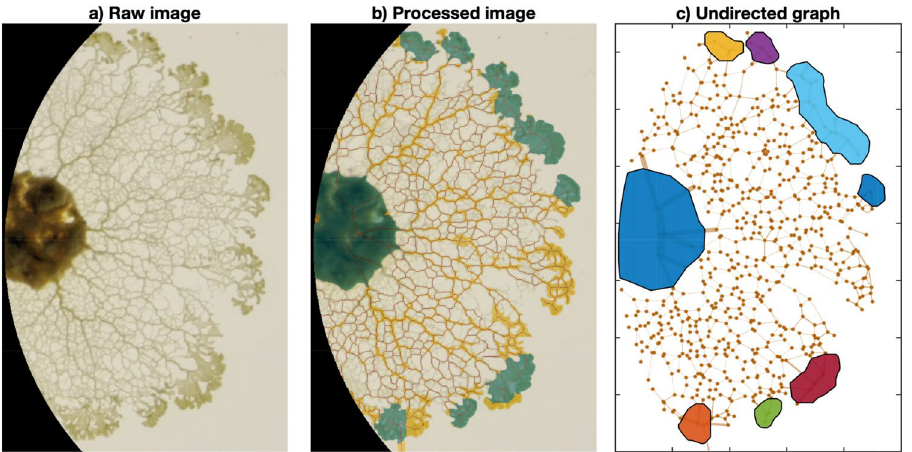
Figure 1. Segmentation process. ( a ) Raw image, masked at the boundary of the petri dish and enhanced used a Laplacian filter. ( b ) Segmented image overlay on original image, with highlighted pseudopods and cell topological skeleton. ( c ) Resulting undirected graph: dots and segments correspond to nodes and edges respectively. Approximate location of clusters shown as colored polygons. Three videos exemplifying the time- lapse segmentation process are available as supplementary material of this study. Figures generated using Matlab 2019a (https ://www.mathw orks.com/produ cts/matla